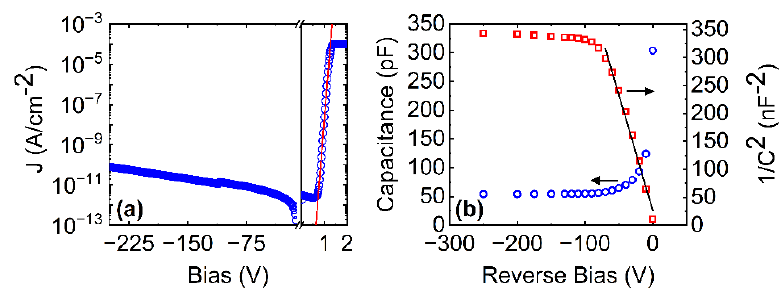
Fig. 2. (a) Semilogarithmic plot of current density as a function of forward and reverse bias for a Ni/20  m-4H-SiC SBD. The solid line is a linear fit of Eq. (1) to the forward 𝑙𝑛𝐽 - 𝑉 plot. (b) Variation of detector capacitance (left y-axis) measured at 1 MHz test frequency as a function of reverse bias voltage and the corresponding Mott-Schottky plot (right